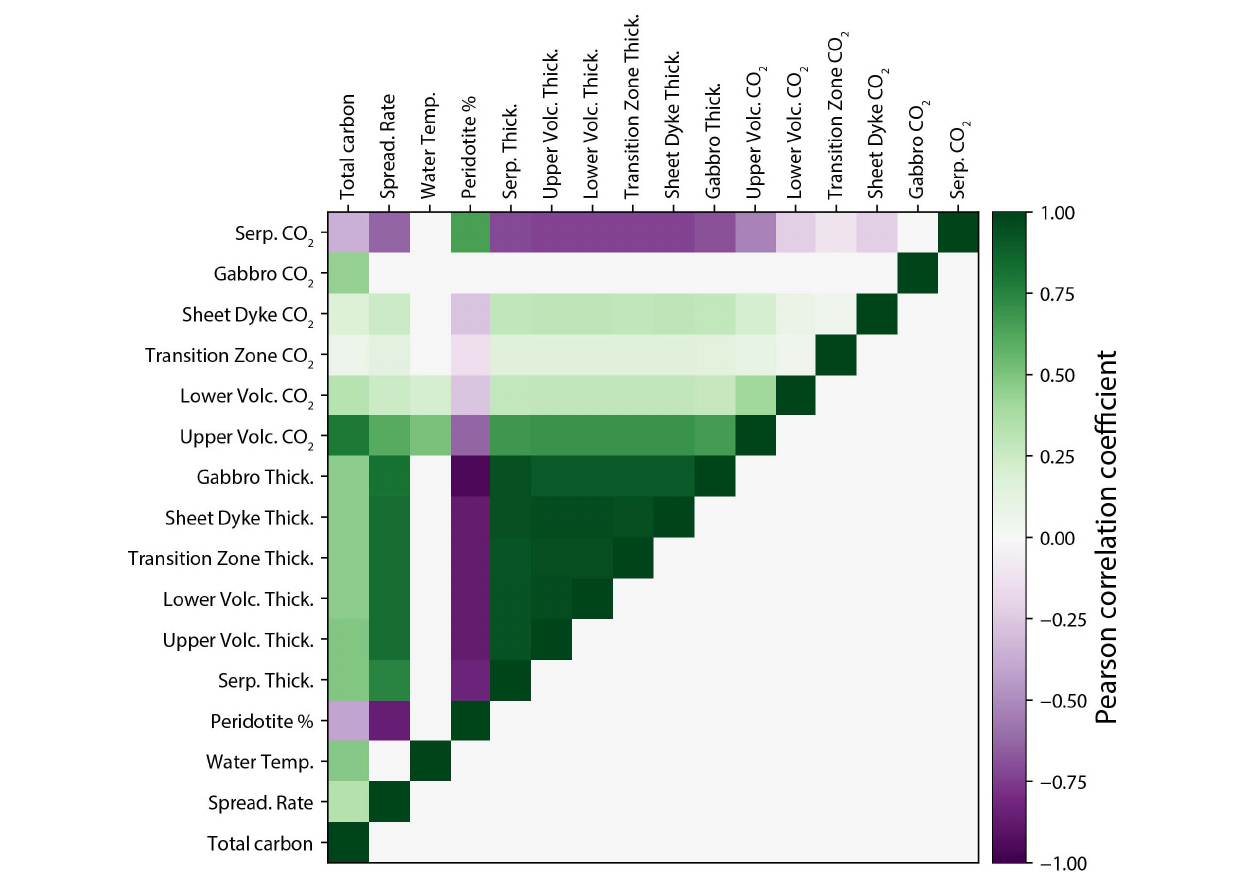
FIGURE 4 | Pearson correlation coefficients between each parameter that contributes to the total carbon content of any point in the ocean crust. The correlation coefficient is calculated with 10 7 samples drawn at random from the distributions given in Table 1 to ensure a sufficient number of samples across the full range of possible values. The data used to calculate our model follow identical statistical